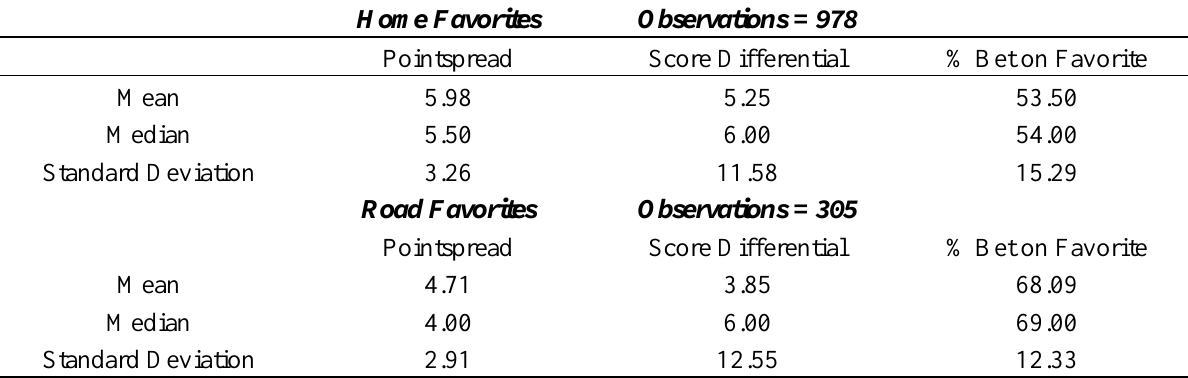
Table 1. Summary Statistics for Women’s National Basketball Association (WNBA) Home and Road Favorites